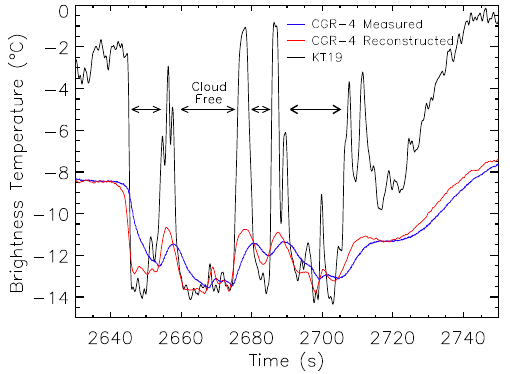
Figure 7. Brightness temperatures of upward terrestrial radiation from KT19 (black) and CGR-4 (blue) on 15 May 2015 above bro- ken clouds. The red line shows the reconstructed CGR-4 data.